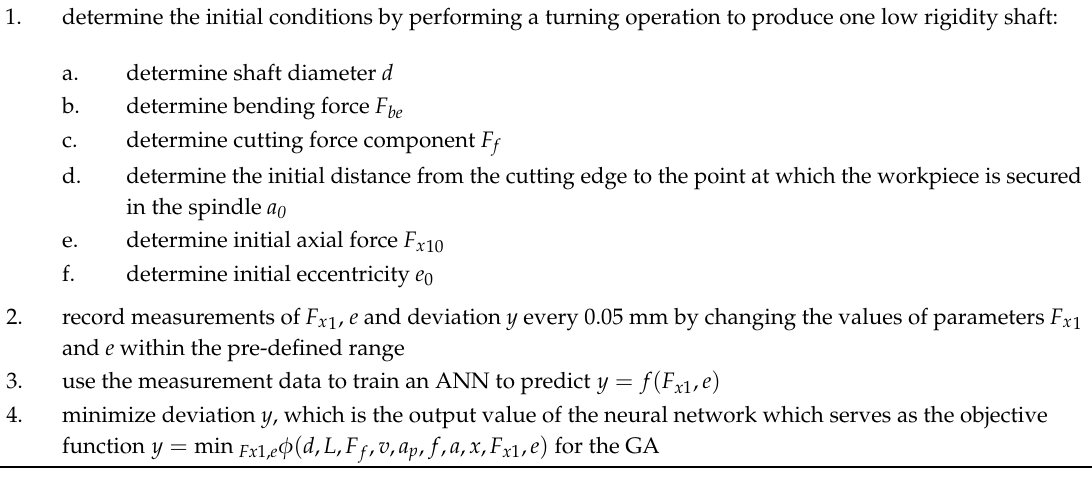
Algorithm 1 Two-dimensional gradient descent search algorithm